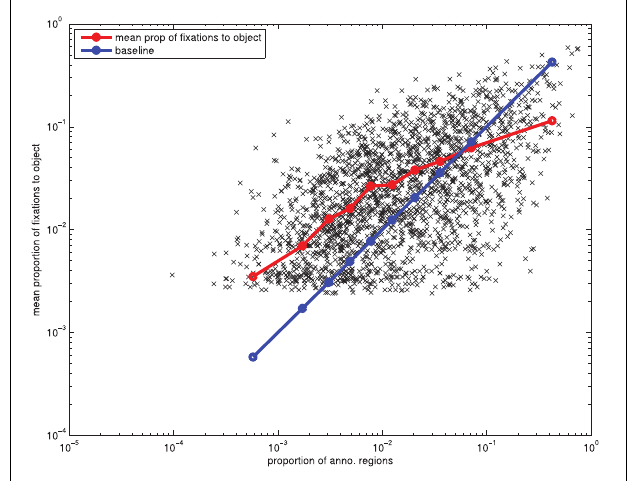
FIGURE 7 | The effect of an object’s area on the proportion of fixations it receives.